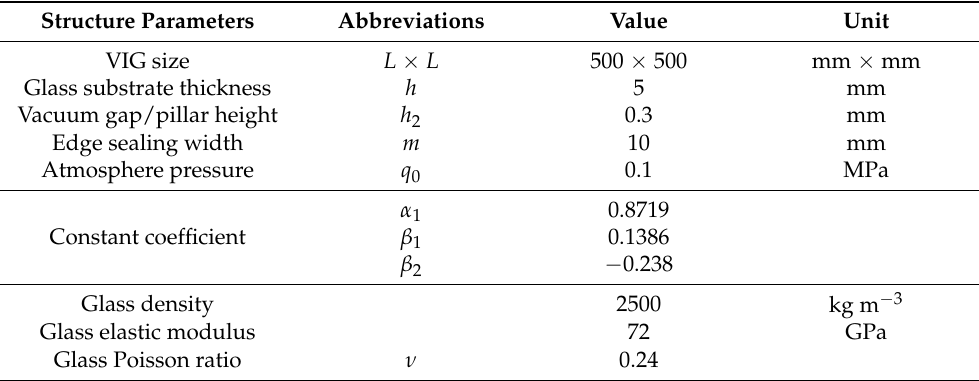
Table 2. Structure parameters of VIG from reference [30].